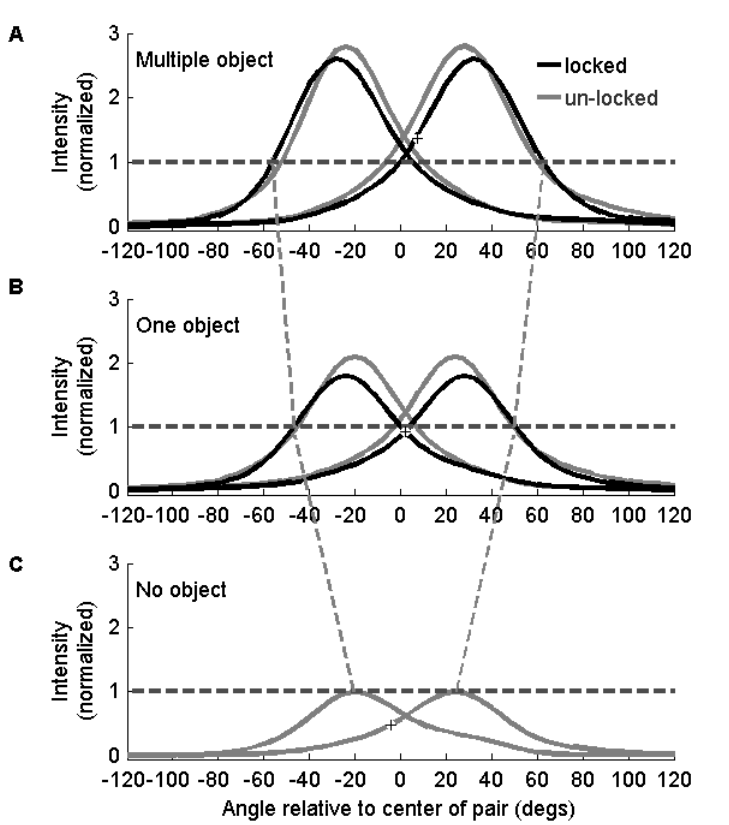
Figure 4. Combined effect of the changes in click intensity and changes in inter-click angle, across the different experimental setups. (A) Multiple-object experiment. (B) One-object experiment. (C) No-object experiment. Dashed gray lines depict the effective increase in field- of-view due to the combined increases in inter-click angle and click intensity; here we assumed a constant hearing threshold at normalized intensity of 1. Horizontal dashed lines, normalized intensity=1; note that in all panels, this intensity was kept constant by the bats around their region of interest (see text). In all panels, ‘‘ + ’’ symbols depict the point of maximum-slope of the right beam (the locked beam when there are two): Note how the maximum slope changes position from being lateral (right) to the target in the multiple-object experiments, to pointing straight at the target in the one-object experiments, to being medial (left) to the target in the no-object experiments.